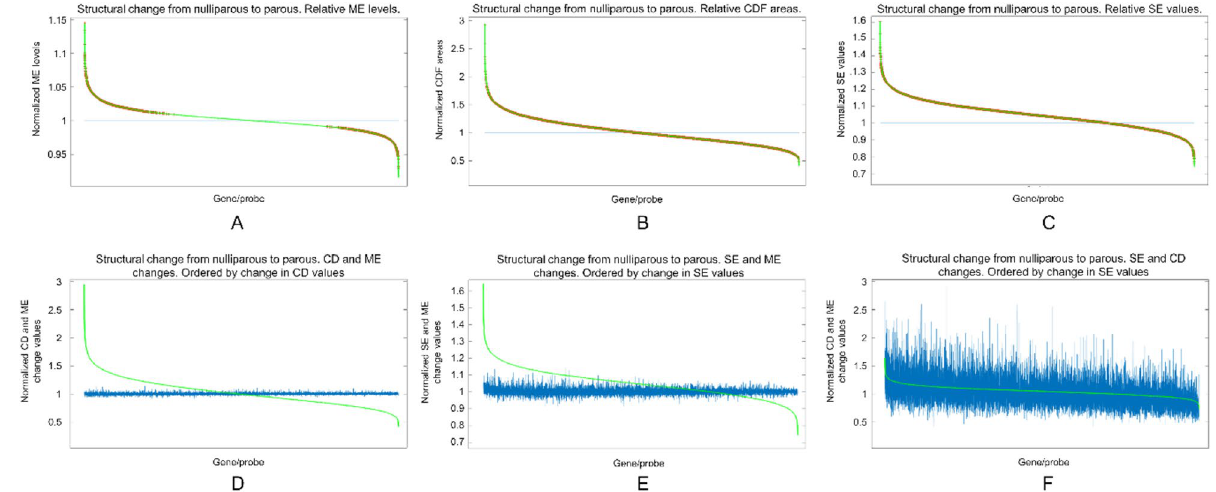
Figure 3. Structural changes associated to FFTP, gene-by-gene analyses. Upper row: The X axis represents each of the 18,653 probes, and the horizontal line at value 1 represents, for each probe in the X axis, its normalized expression value for nulliparous. To show the existence of a specific genomic signature for parous and its different dimensions, the ordered relative mean expression level for each gene in the parous group is depicted by the green curve. The higher the changes associated to FFTP, the more distant the green curve. Statistical significance is marked in red. (A) Restructuration of mean expression levels and general tendency to upregulation after FFTP. (B) Existence of distinct channels and stimuli affecting the genes after FFTP. (C) Changes in the number and complexity of functions performed by each gene after FFTP. Bottom row: The X axis represents each of the 18,653 probes. For each pair of criteria, the simultaneous changes are depicted. ( D ) Simultaneous changes in CD and ME (ρ = -0.1383). ( E ) Simultaneous changes in SE and ME (ρ = 0.0974). ( F ) Simultaneous changes in SE and CD (ρ =